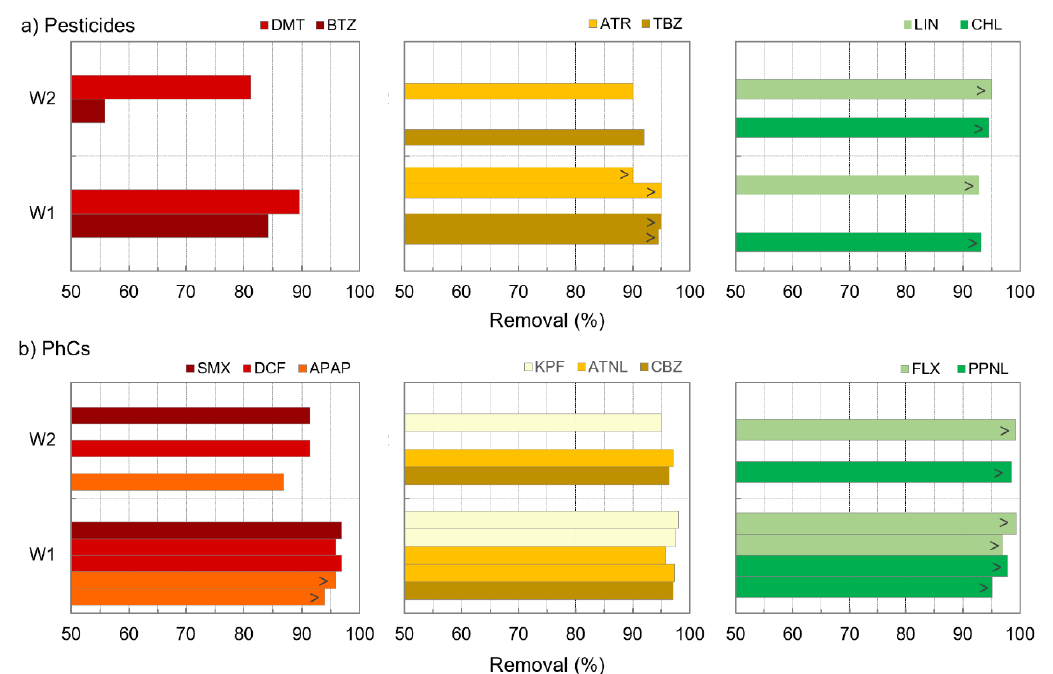
Figure 6. Removal of individual pesticides ( a ) and PhCs ( b ) presenting different amenabilities to PAC adsorption as a function of intake water, W1 or W2 (trials with similar PAC doses and different intake waters were compared; 8–11 mg/L PAC for pesticides and 11–13 mg/L PAC for PhCs; “>”for removals computed with LOQ).